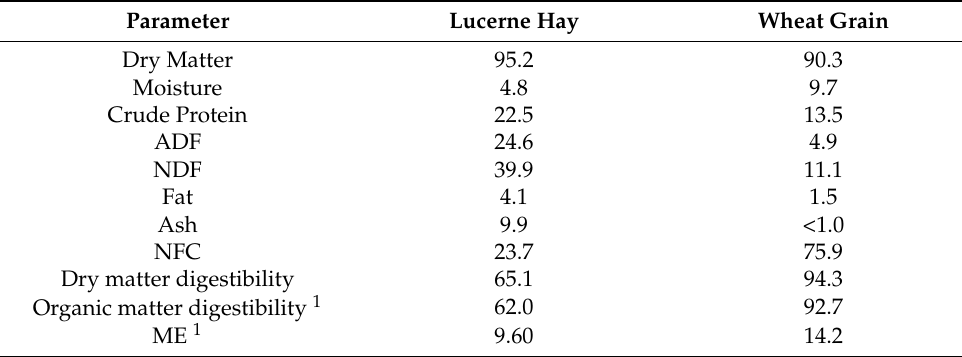
Table 1. Chemical composition of wheat grain and lucerne hay used as substrates.